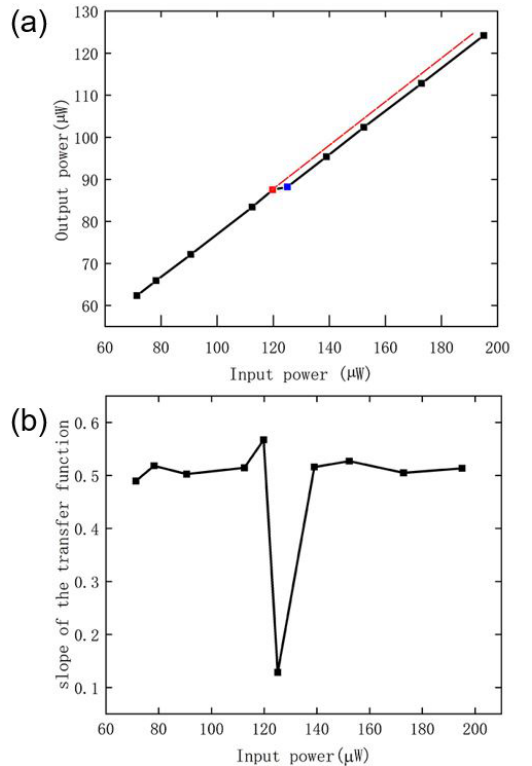
Figure 3. ( a ) Power transfer function: the output power of the laser (right) when the input power of the seed (left) laser is varied by the VOA; ( b ) the slope variation as a function of input